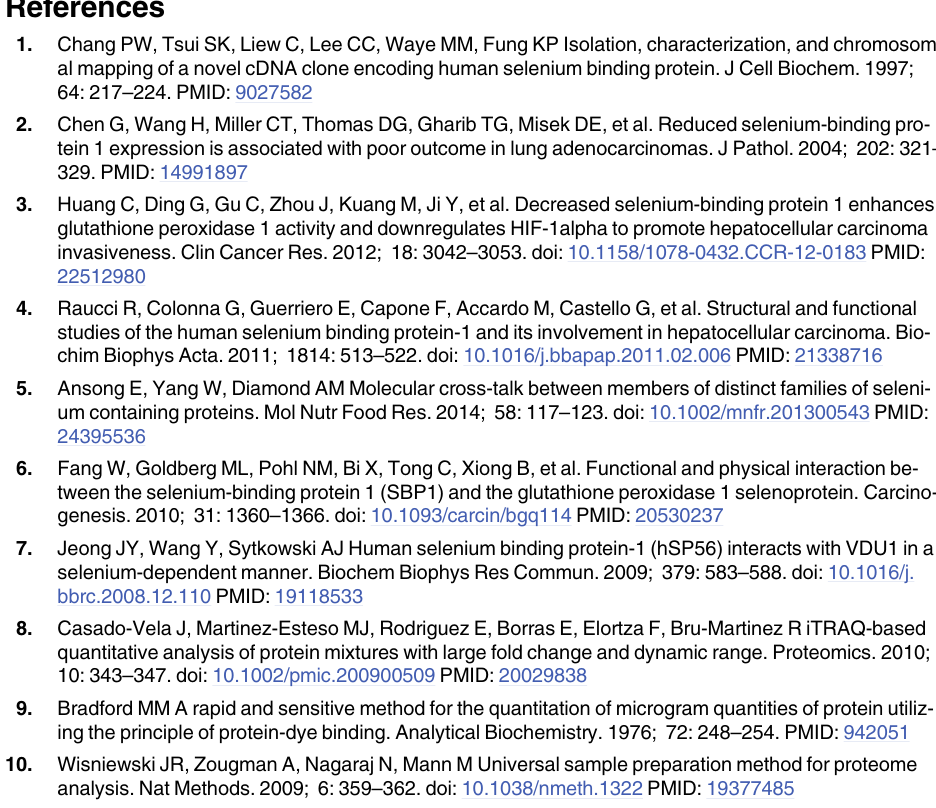
S1 Table. All peptides and proteins identified by iTRAQ. S2 Table. Detailed information of differentially accumulated proteins in response to SBP1 induction. S1 Fig. Validation of iTRAQ proteomic results by western blot analyses. (TIF) S2 Fig. MS/MS data of six valided